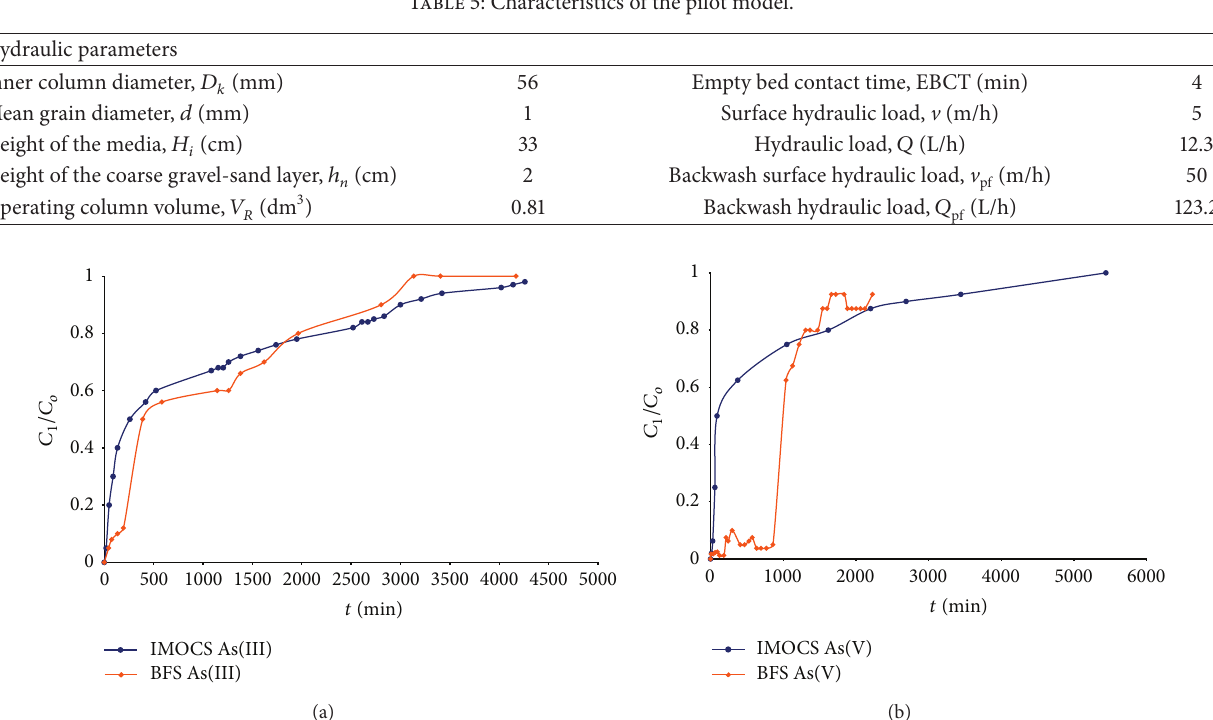
Table 5: Characteristics of the pilot model.